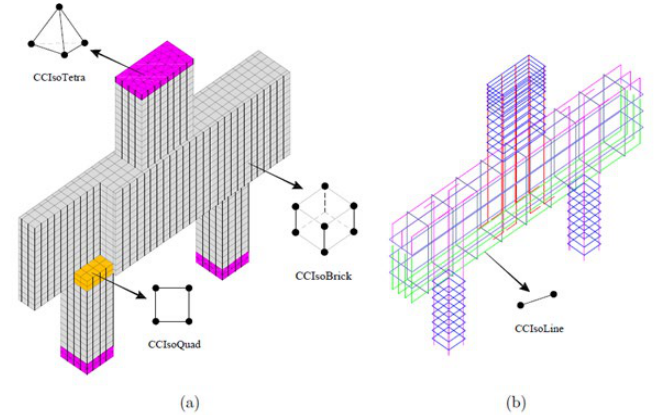
Figure 4. Discretization of solid (a) and linear (b)